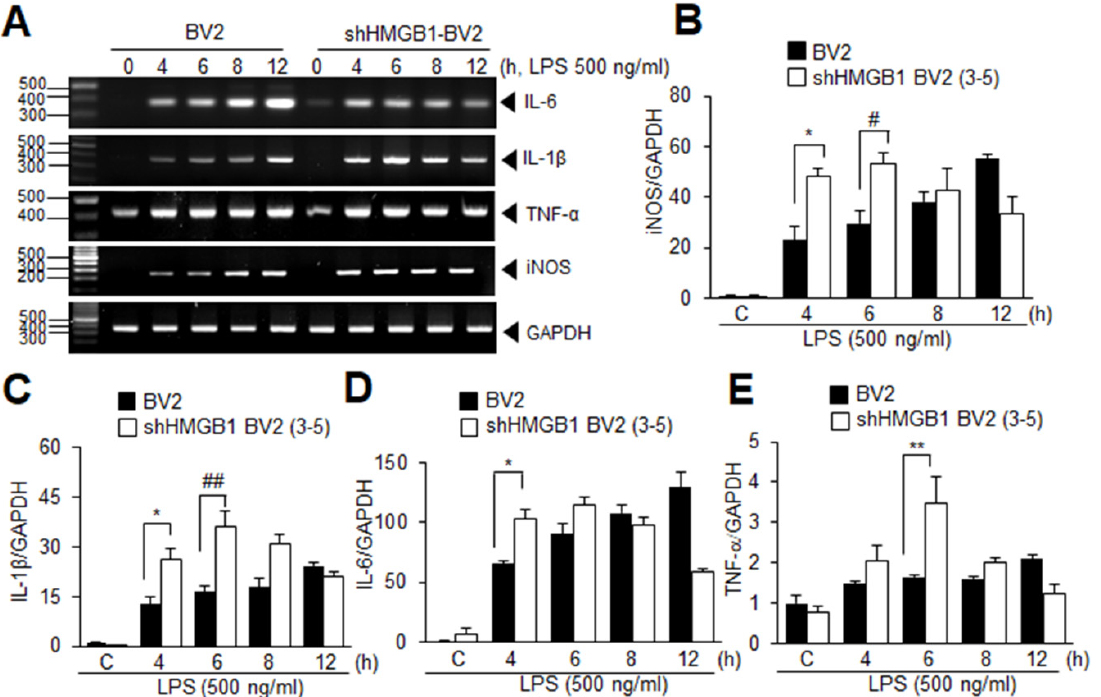
Figure 5. Induction of pro-inflammatory cytokine expression is enhanced in LPS-treated HMGB1 KD BV2 cells. BV2 or shHMGB1-BV2 cells were treated with LPS (500 ng/mL) for 4, 6, 8, and 12 h, and expression of iNOS, IL-1 β , IL-6, and TNF α was examined using RT-PCR analysis. Representa- tive results are presented in ( A ) and quantification results are presented as the mean ± SEM in ( B –